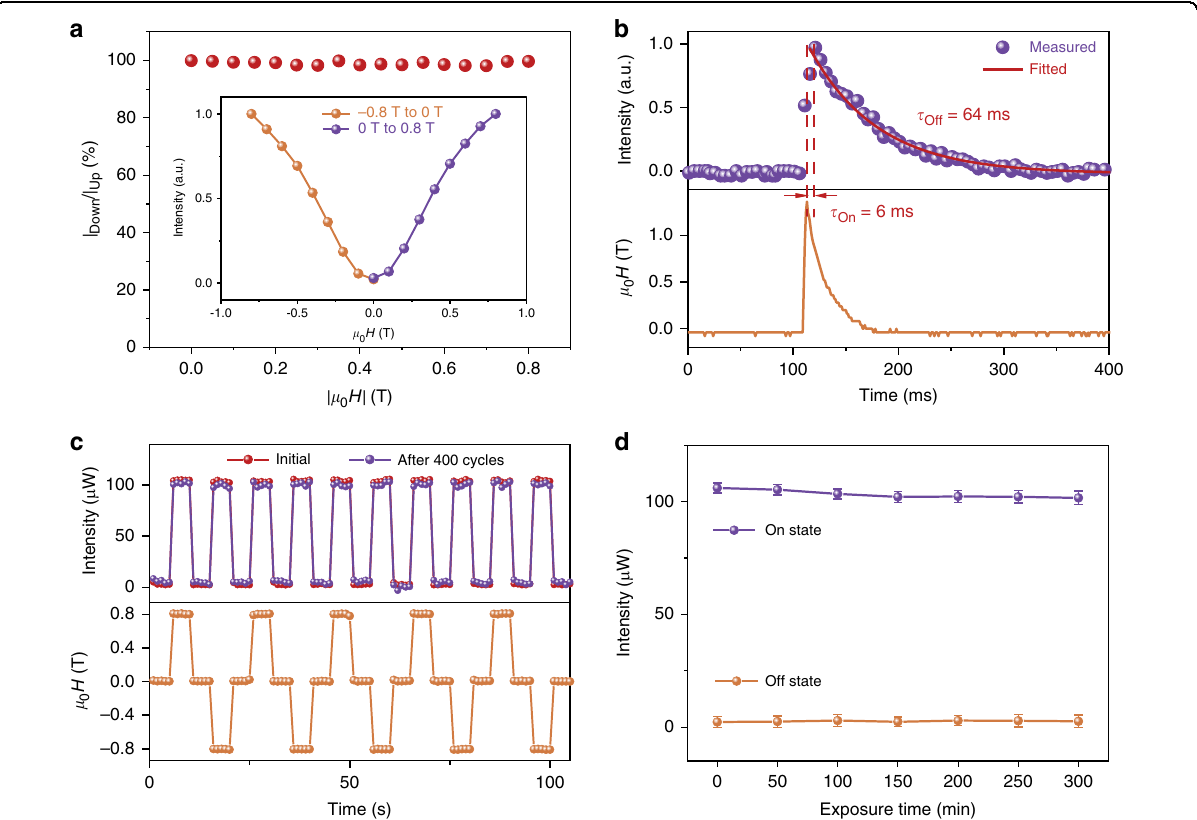
DUV light 47 ffiffiffiffiffiffiffiffiffiffiffiffiffiffi q δ ð H Þ ¼ m π þ 2sin (cid:2) 1 I (cid:2) I min for m ¼ 0 ; 2 ; 4 ¼ I max (cid:2) I min ffiffiffiffiffiffiffiffiffiffiffiffiffiffi q δ ð H Þ ¼ m þ 1 ð Þ π (cid:2) 2sin (cid:2) 1 I (cid:2) I min for m ¼ 1 ; 3 ; 5 ¼ I max (cid:2) I min ð 1 Þ where m is the number of peaks observed in transmitted intensity, I is the intensity at observed state, I max and I min are the intensity when the transmission axis of analyzer